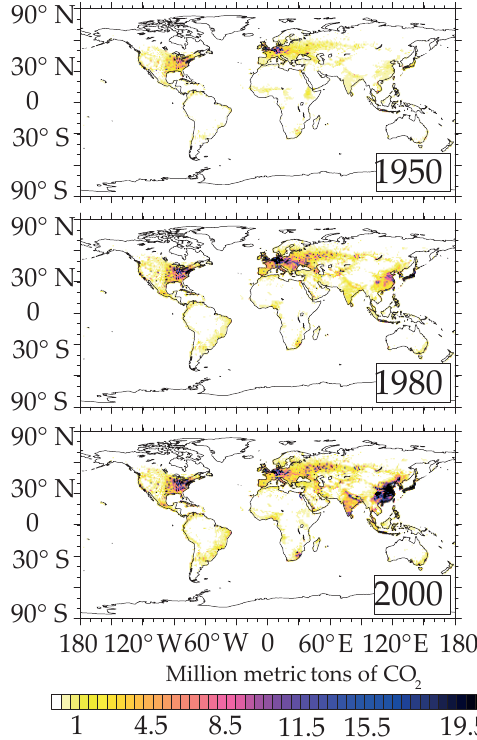
Figure 3. POPEM CO 2 emission estimates for 1950, 1980, and 2000. POPEM produces a gridded representation of anthro- pogenic CO 2 emissions using population dynamics and country per capita emissions derived from the CDIAC database. Values are given in millions of metric tons per